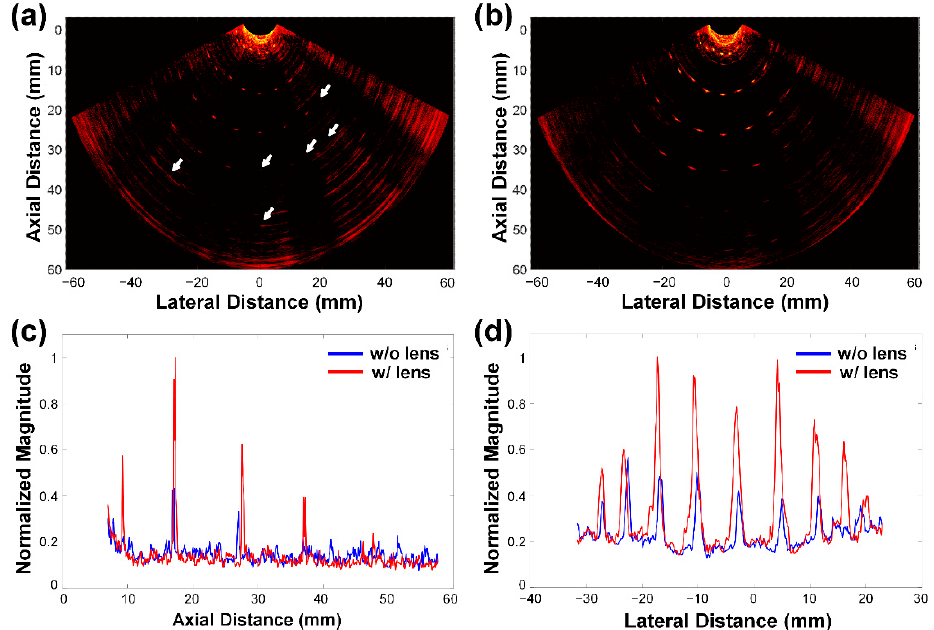
Figure 9. PA images of tungsten wire targets, ( a ) without and ( b ) with the developed optical lens. The white arrows in ( a ) indicate the invisible wire targets on the PA image in ( a ), but visible in ( b ). ( c , d ) Normalized envelope profiles of the wire target images along ( c ) the axial direction at the center position in the lateral direction and ( d ) the lateral direction at a depth of 28 mm.